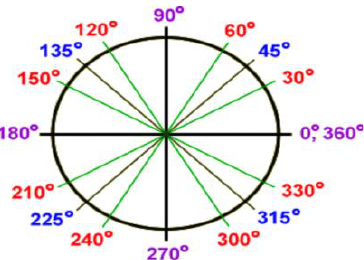
Figure 2. The multi-qubit octal states depiction of the proposed model.